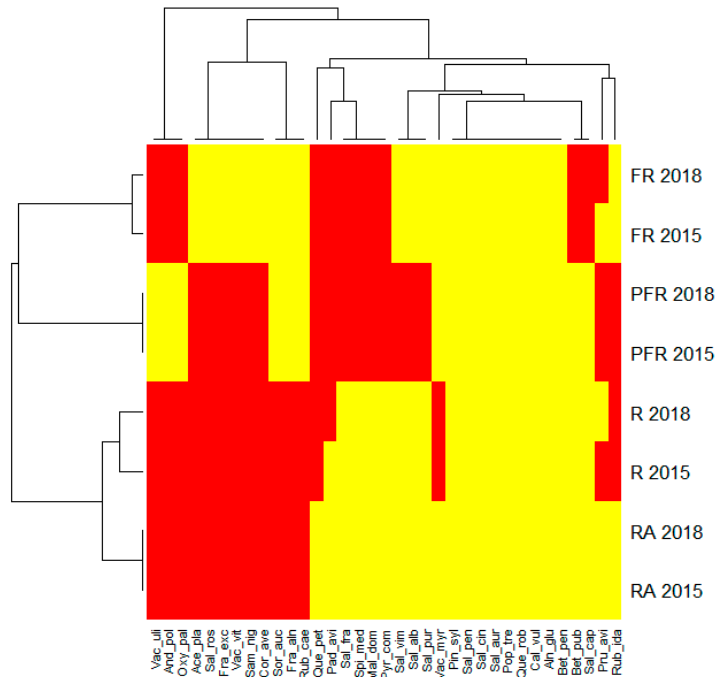
Figure 4. A dendrogram and a heatmap of the hierarchical cluster analysis of 35 species and four sectors in 2015 and 2018 based on Jaccard’s coefficient and the average linkage method (the presence of a given species in the phytocoenoses is marked with yellow colour, and its absence with red colour ).